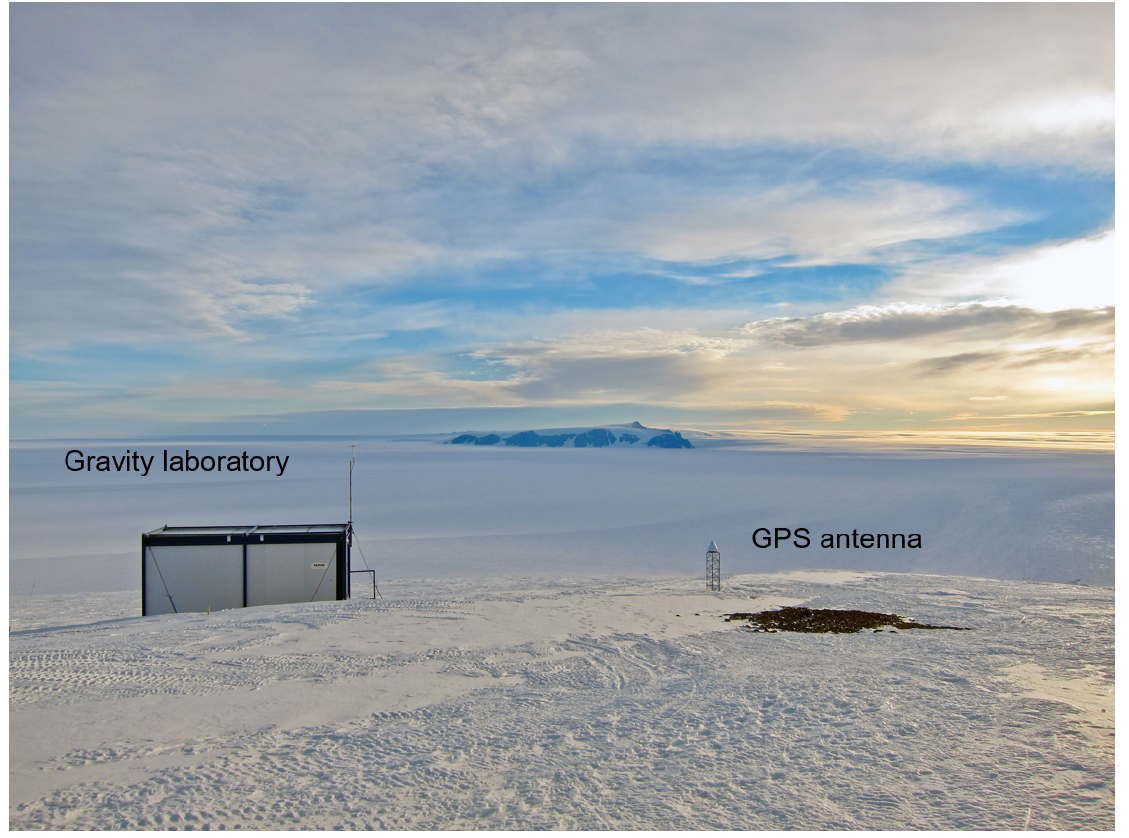
Figure 2. Aboa GPS antenna ( right ) next to the gravity laboratory ( left ) where the receiver is located (Photo Credit: Jyri Näränen,